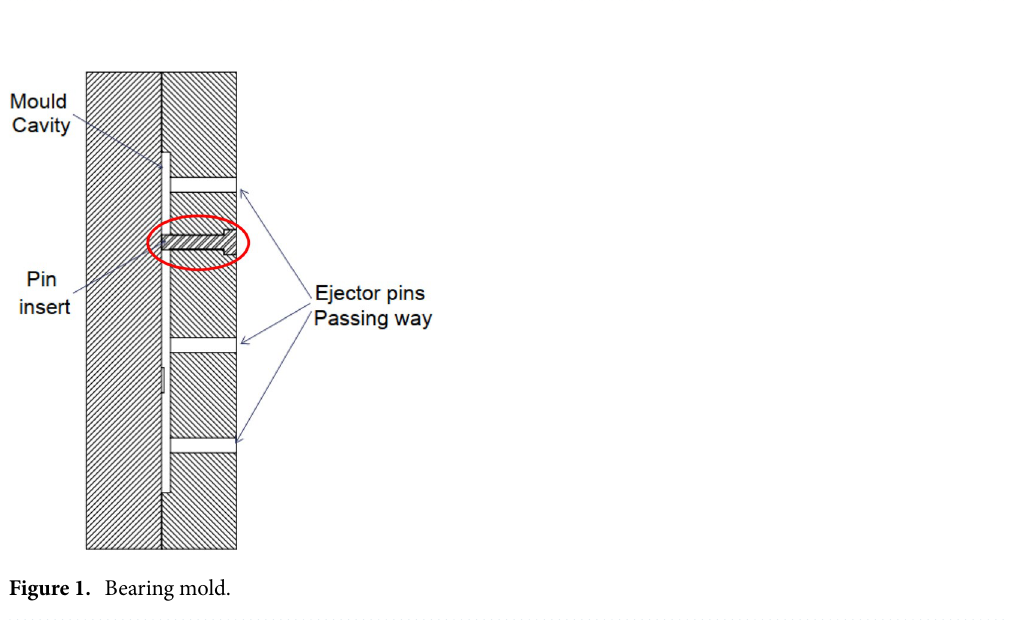
Table 1. Injection parameters. a Injection speed percentage of the maximum injection speed.